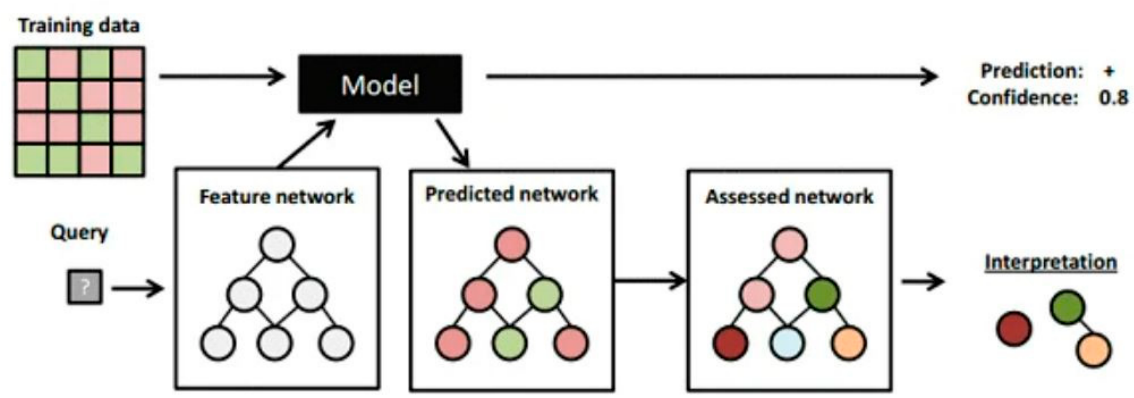
Figure 2. Deep-learning (DL) combination framework.